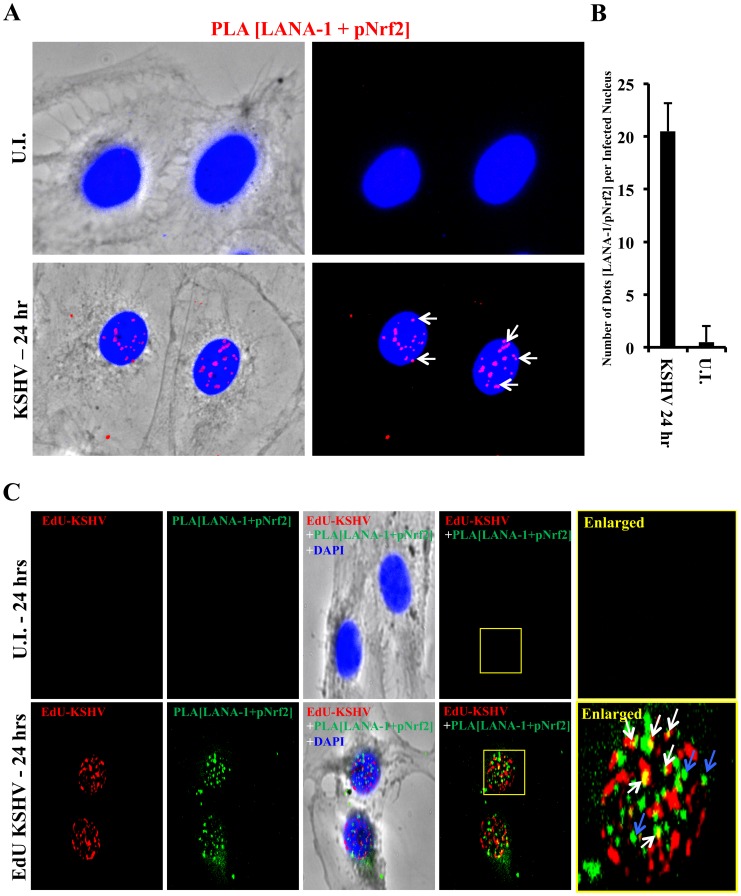
Colocalization of pNrf2 with KSHV genome and LANA-1.
A) Proximity ligation assay (PLA) on uninfected (U.I.) and KSHV-infected cells (20 DNA copies/cell) for 24 hr. Cells were incubated for 1 hr with antibodies against pNrf2 (rabbit) and LANA-1 (mouse monoclonal), washed, incubated for 1 hr with species-specific PLA probes and 2 additional oligonucleotides to facilitate the hybridization only in close proximity (<16 nm). A ligase was then added to join the two hybridized oligonucleotides to form a closed circle and initiate a rolling-circle amplification using the ligated circle as a template after adding an amplification solution to generate a concatemeric product extending from the oligonucleotide arm of the PLA probe. Lastly, a detection solution consisting of fluorescently-labeled oligonucleotides was added, and the labeled oligonucleotides were hybridized to the concatemeric products. The signal was detected as distinct fluorescent dots. Negative controls consisted of samples treated as described but with only secondary antibodies. Confocal microscopy was used for imaging. Red dots represent LANA-1 and pNrf2; blue staining = DAPI; white arrow = PLA dot [LANA-1+pNrf2] interaction. B) Quantification of the number of dots in the nuclei of infected HMVEC-d cells were obtained from 3 independent, representative fields, containing ∼30 cells each. C) HMVEC-d cells were infected with EdU-labeled KSHV and PLA for pNrf2 and LANA-1 (green dots) was performed as described in Figure 11A prior to staining for EdU-KSHV (red). White arrows indicate the yellow colocalization spots between LANA-1+pNrf2 (PLA green spots) and EdU-KSHV genome (red). Blue arrows indicate the LANA-1+pNrf2 (PLA red spots) not colocalizing with EdU-KSHV genome.